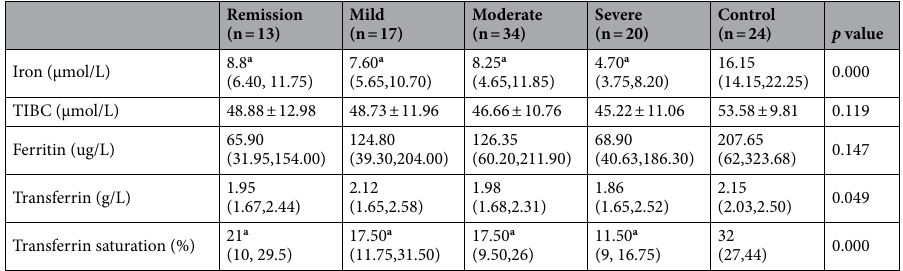
Table 3. Comparison of the serum indicators among patients classified by SES-CD and controls. TIBC: total iron binding capacity. For TIBC: One-way ANOVA. For the other parameters: Kruskal–wallis H test. p < 0.05 means that the distribution of values in each group is not equal. The letter a means that the difference is significant when compared to the controls